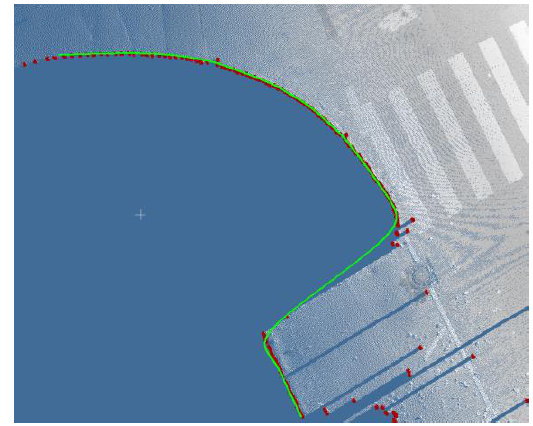
Figure 9. Result of curbstone edge detection and vectorisation using 4 th order